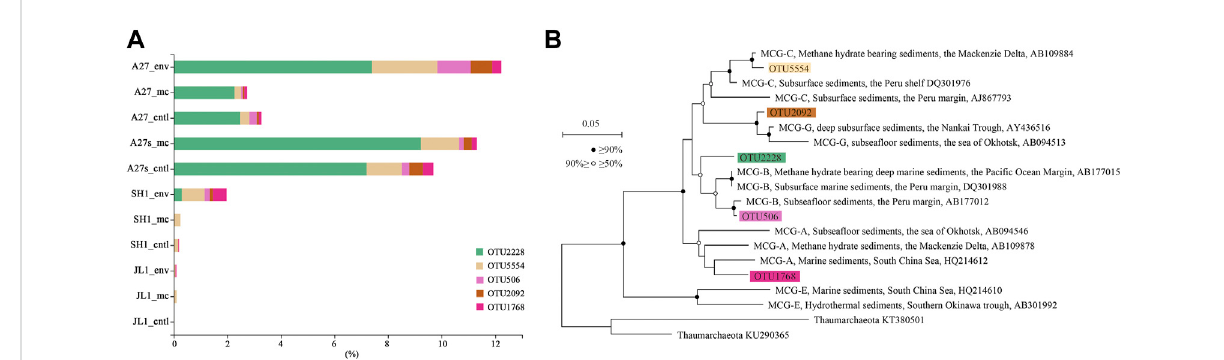
FIGURE 6 Community abundanceand lineage ofenrichedOTUs inthephylum Bathyarchaeota. (A) . The top fi veOTUs inthephylumBathyarchaeota. (B) . Neighbor-joining 16S rRNA gene tree showing the placement of representative members of Bathyarchaeotal relative to environmental sequences, including genes recovered from marine sediments. Thaumarchaeota 16S rRNA sequences from reference genomes were used as an outgroup. Bathyarchaeota (formerly MCG) groups are mainly based on a previous classi fi cation (Meng et al., 2014).The stability of the topology was evaluated by bootstrapping (1,000 replicates). Nonparametric support values are indicated with white ( ≥ 70%) and black ( ≥ 90%) circles. The